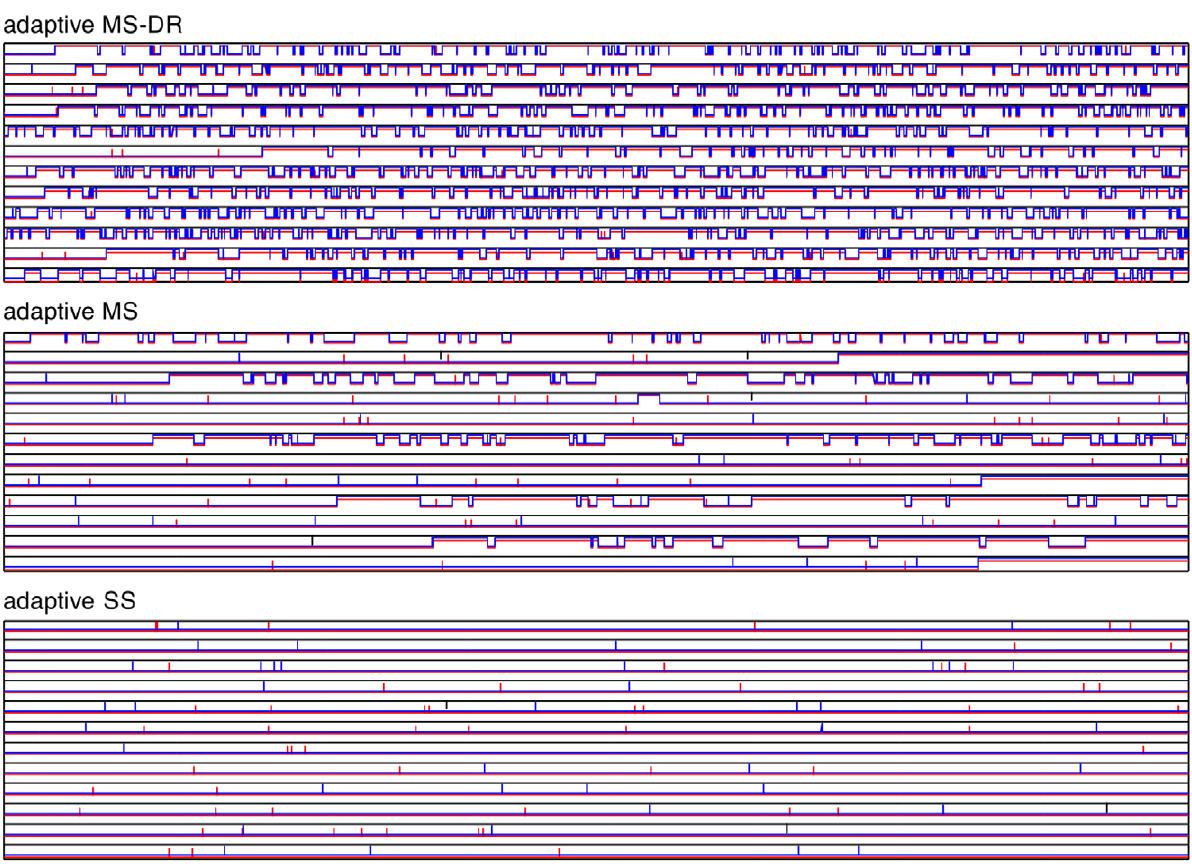
Figure 4. MCMC traces of the three SNPs related to convergence problems in LDL-C data. Each subplot contains traces (including burn-in period) from 12 chains, where each trace is composed of three lines (red for snp1, blue for snp2 and black for snp3), which may be in upper state ( c j ~ 1 ) or lower state ( c j ~ 0 ). c snp3 ~ 1 almost always, whereas c snp1 and c snp2 are mostly synchronized: almost always 0 for SS, often 1 for MS-DR, but changing states often and mixed for MS (some chains are like SS, some more like MS-DR but with poorer mixing). the phenotype (after adjusting for the third SNP using linear regression). Similarly computed single-SNP p-values were 0.09 and 0.15 for the two SNPs. The PVRL2 gene is located near a region with known associations to LDL-C (e.g., the APOE gene) [24].